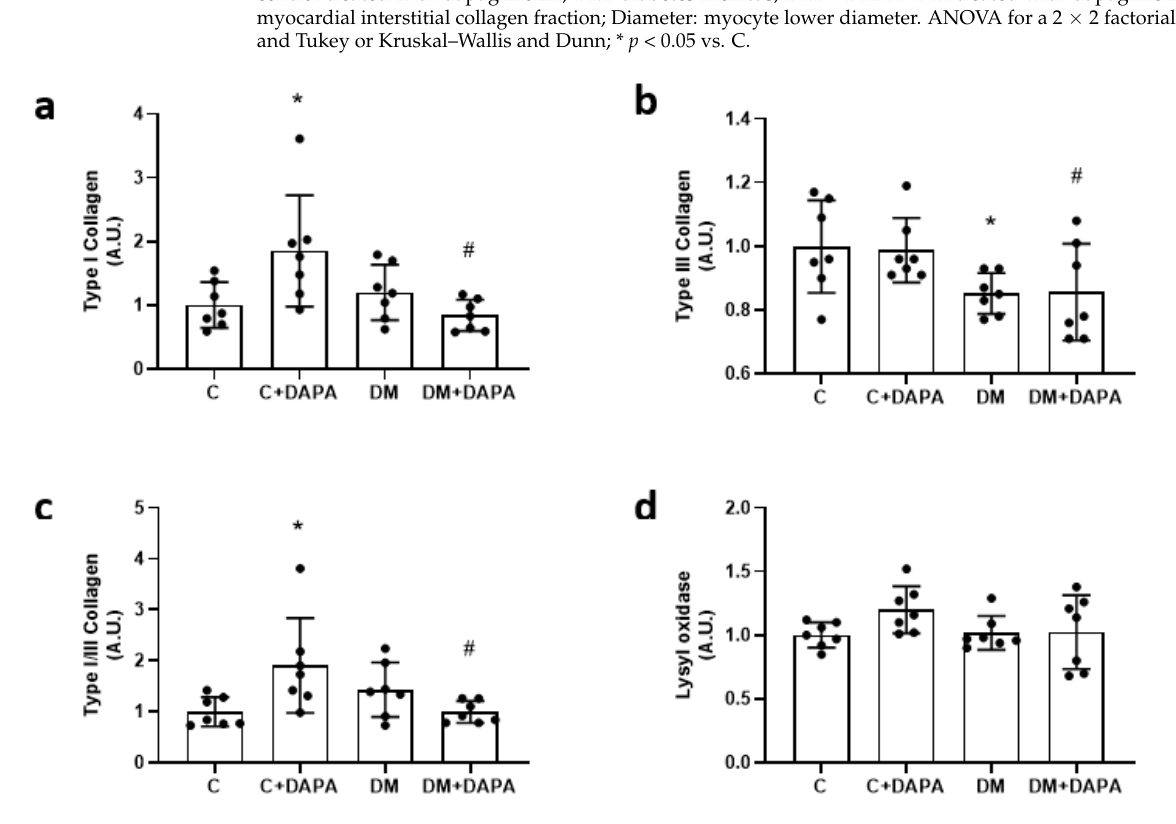
Figure 2. Left ventricular protein expression. Type I collagen ( a ); Type III collagen ( b ); Type I/III collagen ratio ( c ); lysyl oxidase ( d ). Data are mean ± standard deviation. C: control; C + DAPA: control treated with dapagliflozin; DM: diabetes mellitus; DM + DAPA: DM treated with dapagliflozin; ANOVA for a 2 × 2 factorial design and Tukey; * p < 0.05 vs. C; # p < 0.05 vs. C + DAPA; sample size is 7 for all groups. DM had higher myocardial lipid hydroperoxide concentration and lower anti-oxi- dant enzyme activities than C. DM + DAPA had lower lipid hydroperoxide concentration and higher superoxide dismutase and glutathione peroxidase activity than DM (Figure 4). Advanced glycation end products did not differ between groups [C 0.88 (0.67–1.73); C + DAPA 1.29 (0.81–1.66); DM 1.02 (0.71–1.23); DM + DAPA 1.29 (0.80–1.88)%; p > 0.05].